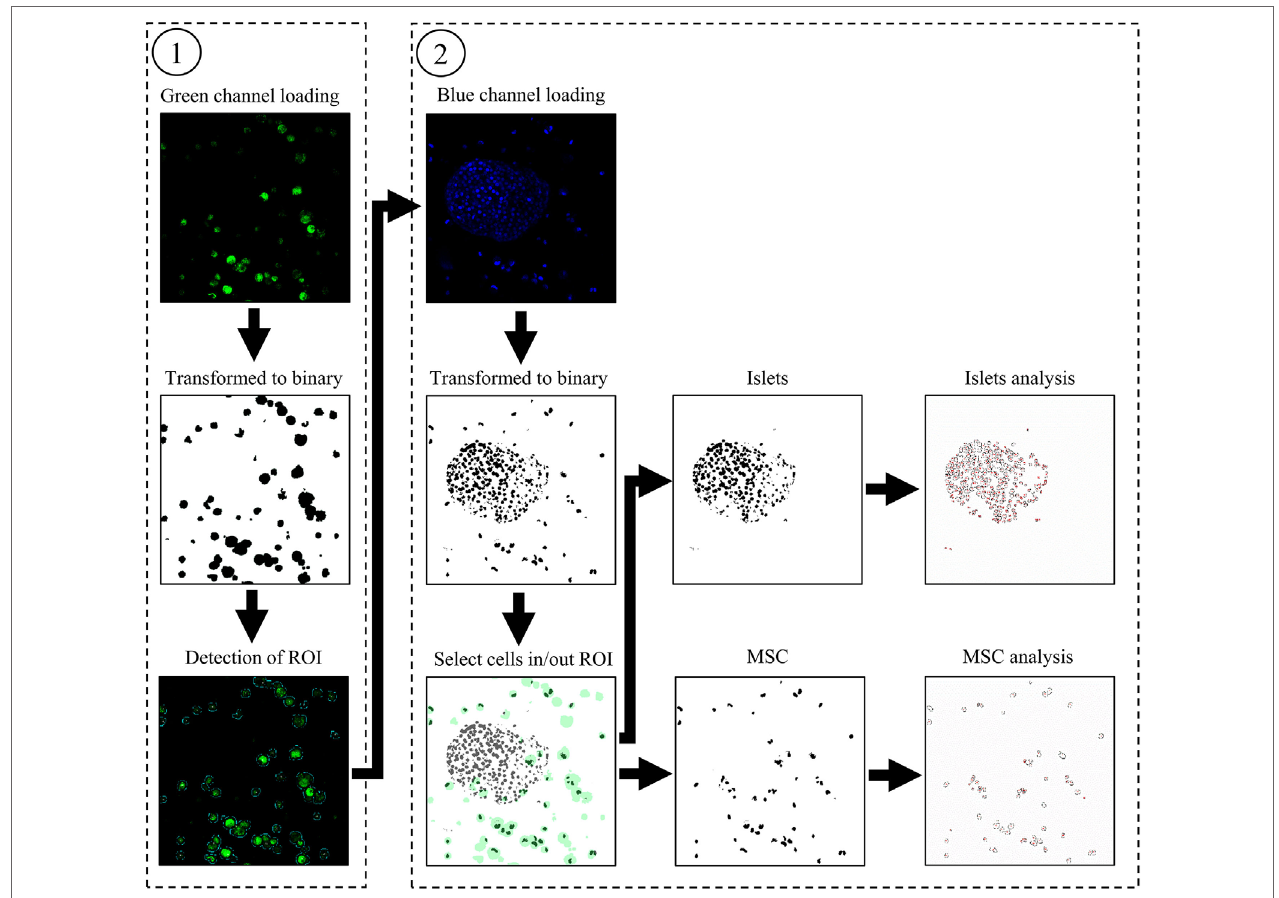
FIgURe 1 | Graphic representation of the automated analyses of the green ① and blue channel ② to detect living nuclei of islets and mesenchymal stem